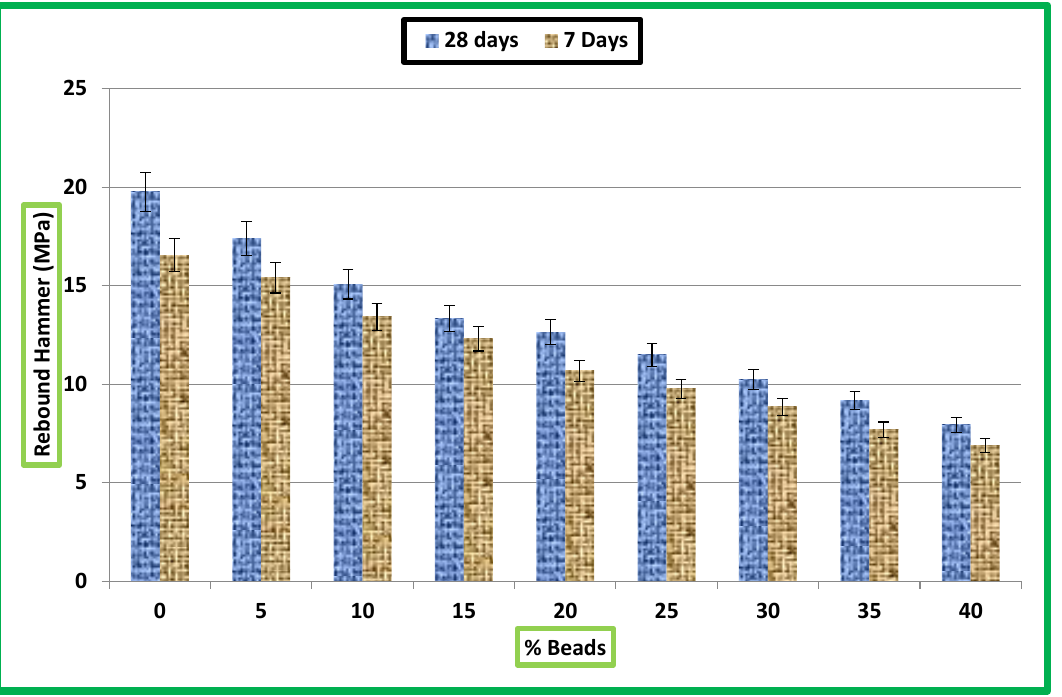
Figure 17. The relationship between density and rebound hammer strength (MPa).